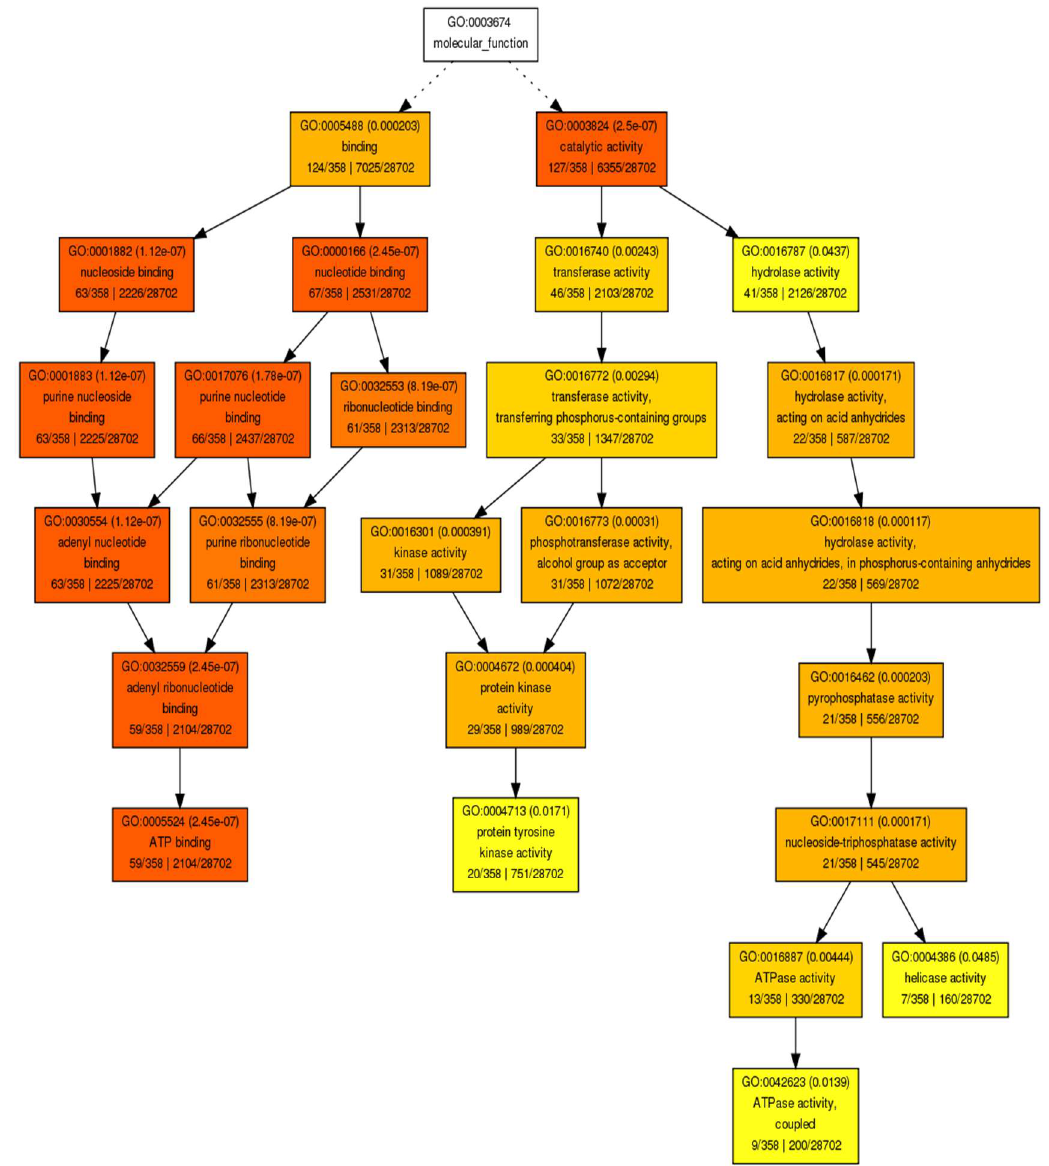
Figure 4. GO terms of the “Molecular function” category represented in genes identified as hypermethylated in ‘Desmayo Largueta’ flower buds in both the “A” = dormant bud stage and “B” = non dormant bud stage.